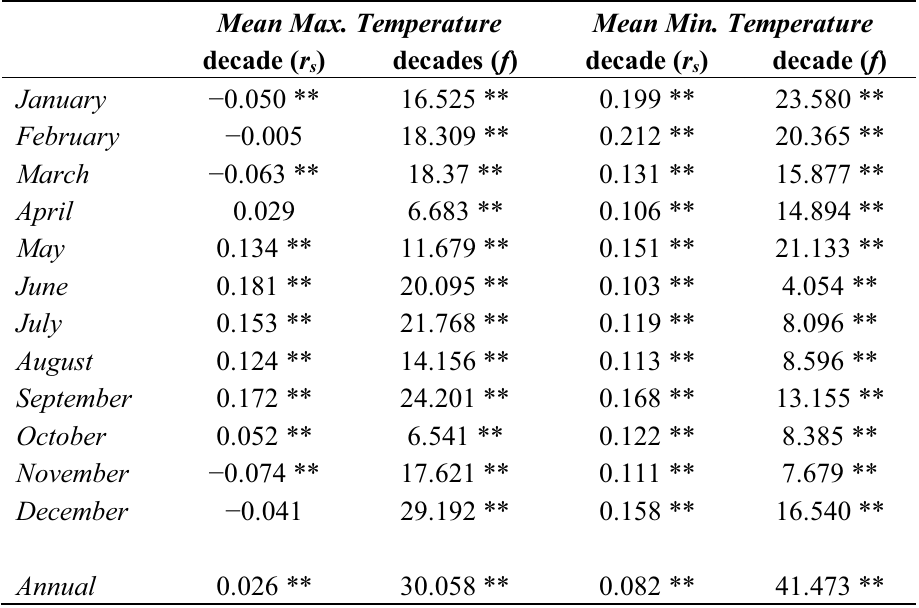
Table 1. Summary of statistical results 1940 (cid:177) 2009 mean monthly minimum ( Min .) and maximum ( Max .) temperatures; results of Spearman (cid:182) s rank correlation for time ( r ANOVA ( f ) testing for difference in decades for each month; statistical values * p < 0.05, ** p < 0.01, *** p <